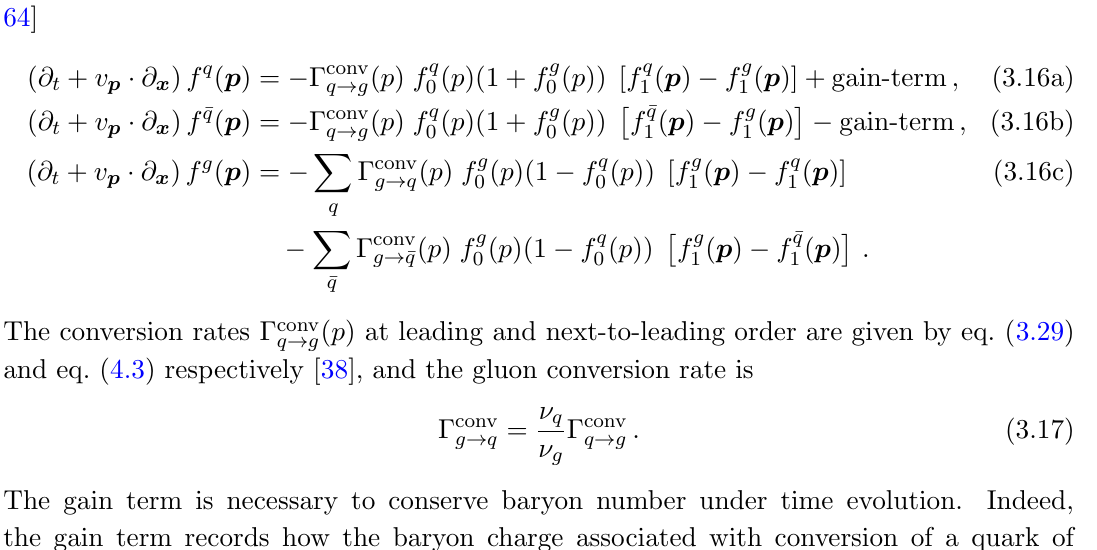
( p ) f g ( p )) 2 , whereas 1 1 (cid:0)